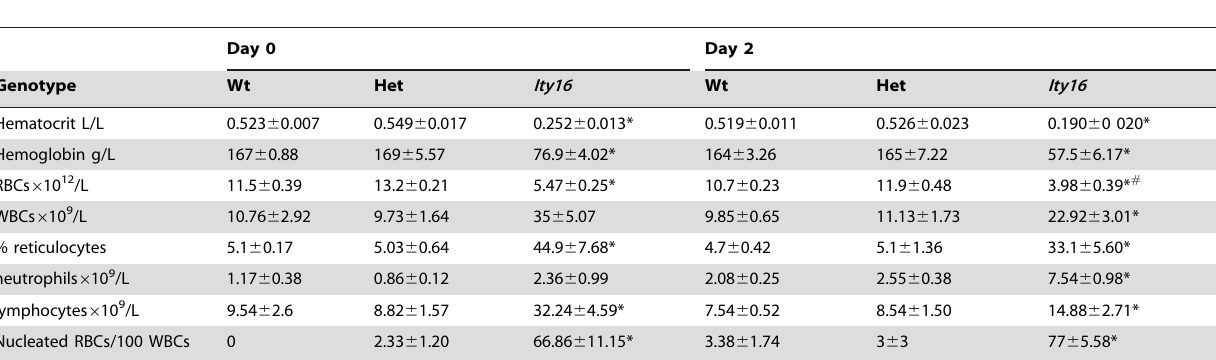
Table 1. Hematologic parameters in Ity16 mutant, heterozygous and wild type mice before (day 0) and after (day 2) infection with Salmonella